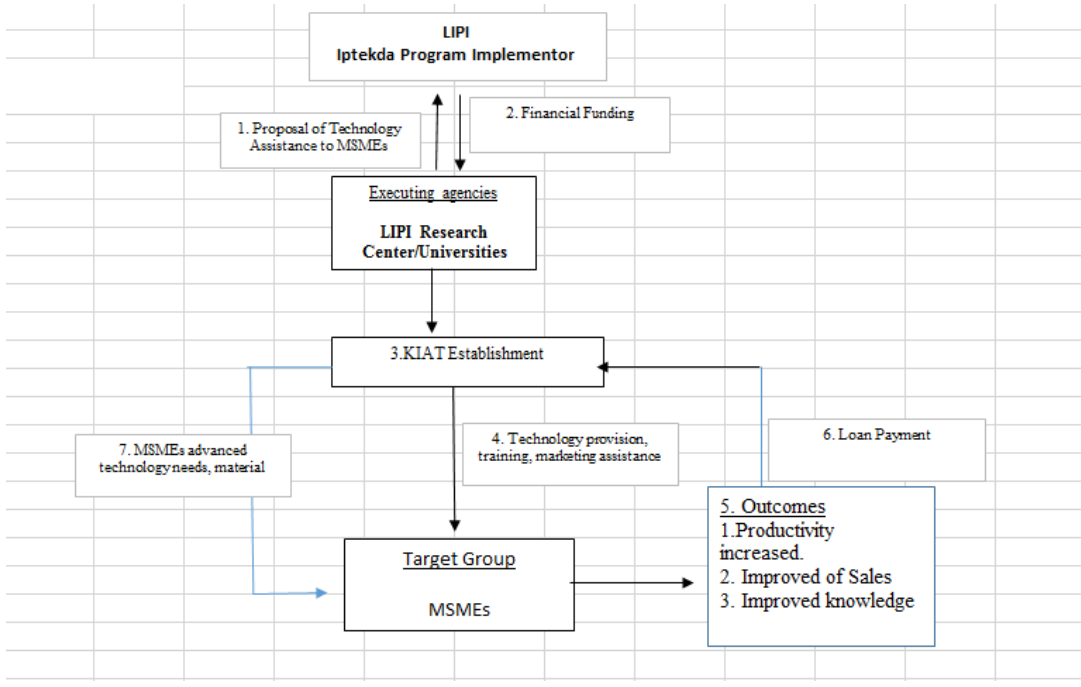
Figure 1. Technology for Regions Program (Iptekda LIPI) (author’s own) [46]. KIAT, Kelompok Intermediasi Alih